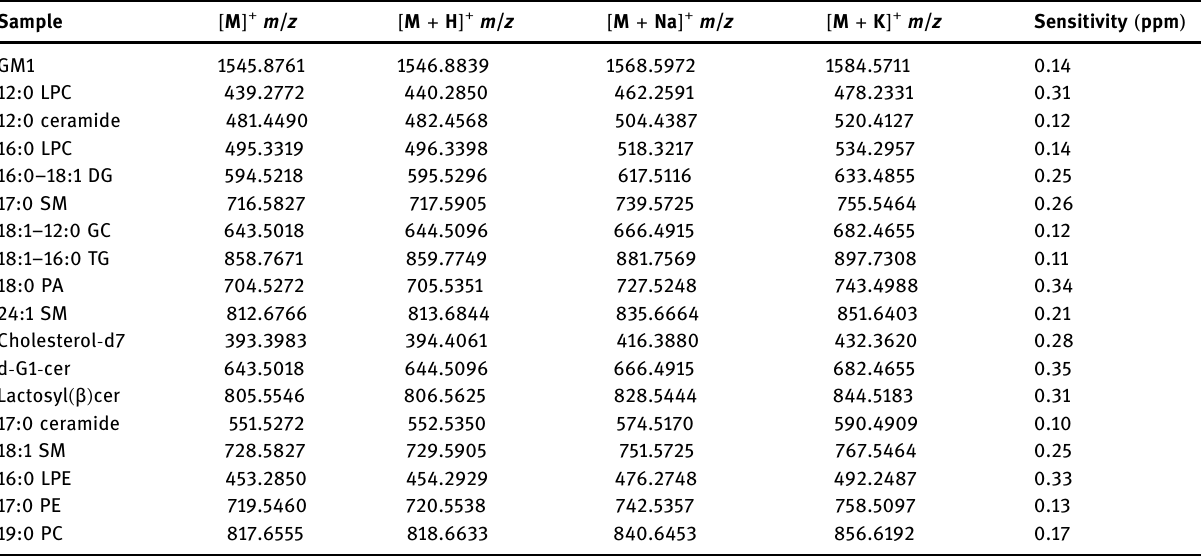
Table 2: Information of lipid standards